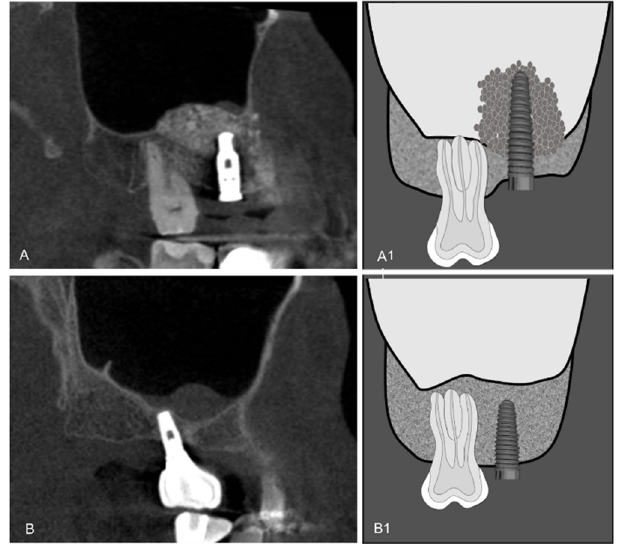
Figure 2. CBCT sagittal reconstruction and schematic drawing of: ( A , A1 ) Dental implants fixed in bone graft and ( B , B1 ) Dental implants fixed in alveolar ridge.